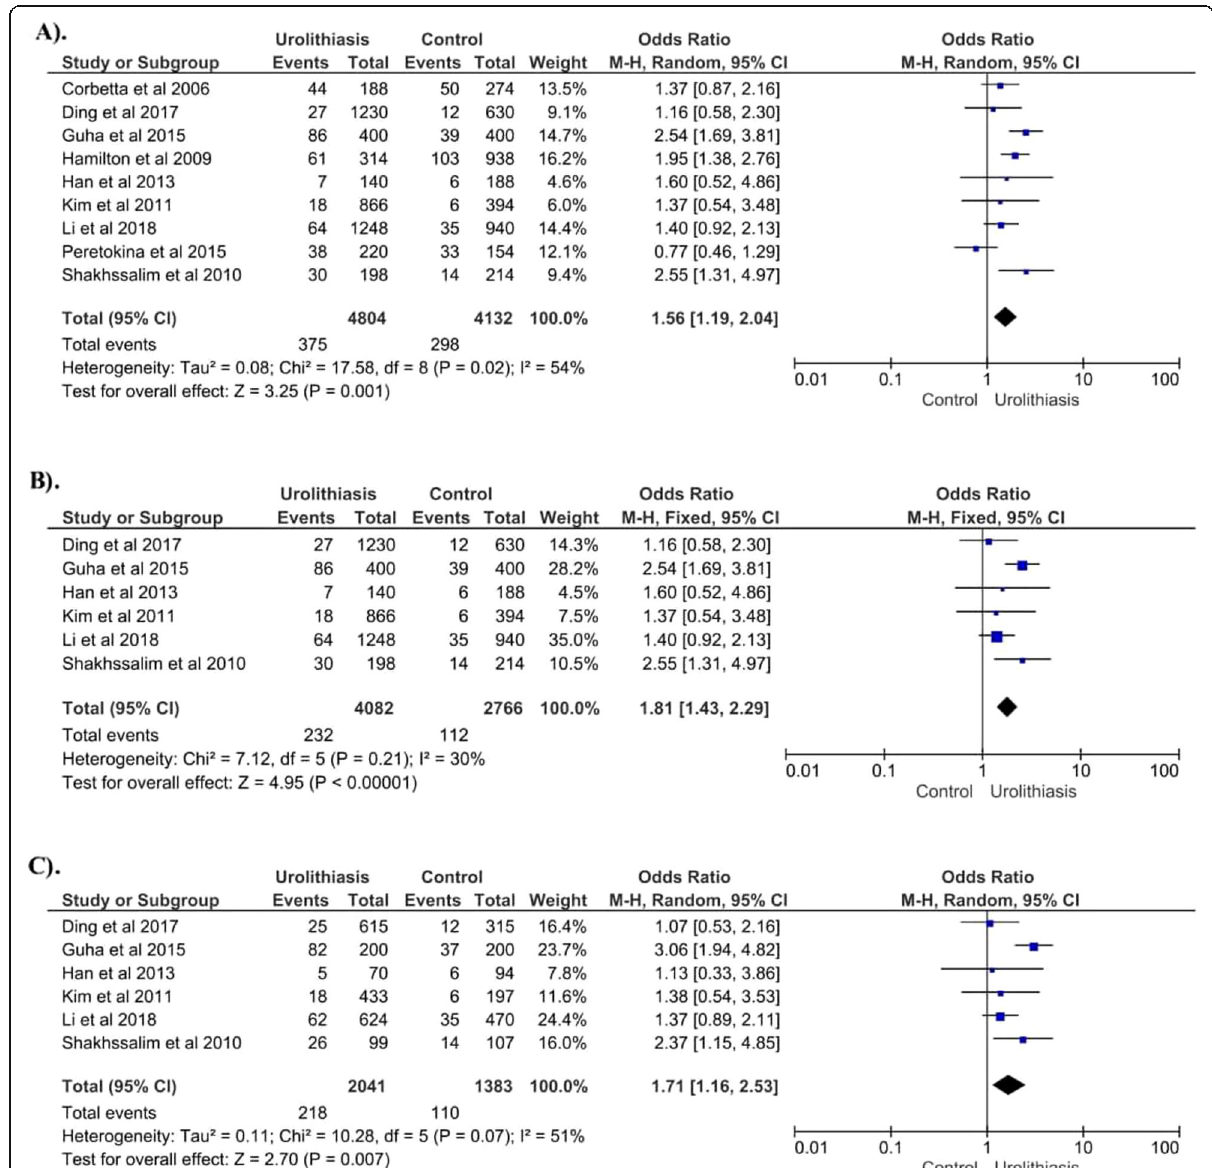
Fig. 3 Forest plot of the association between A986S gene polymorphism and the risk of urolithiasis. a (S vs. A) shows overall correlation. On the other hand, the correlation in Asian sub-group analysis is described in b (S vs. A) and c (AS vs. AA +